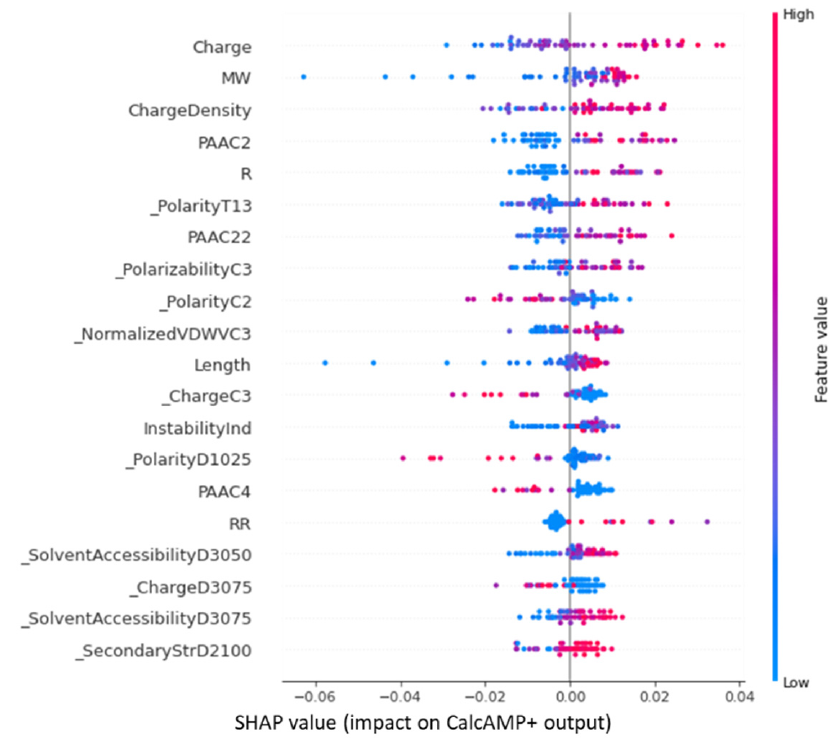
Figure 9. Top 20 feature importance plot and their impact on the external test set prediction for CalcAFP.